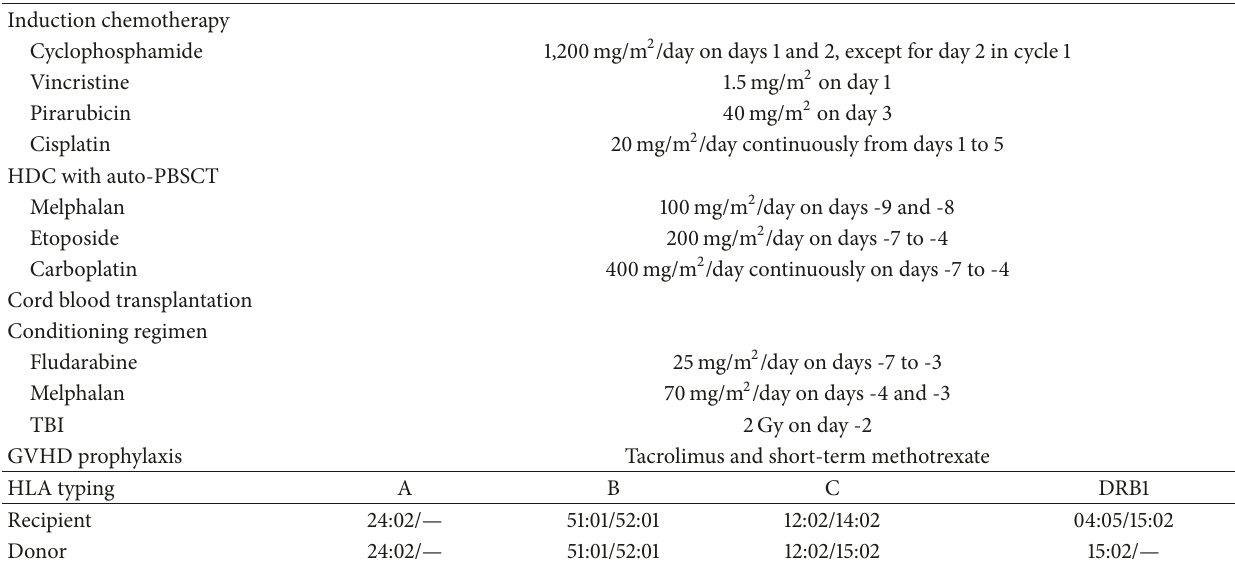
Table 1: Details of chemotherapy and